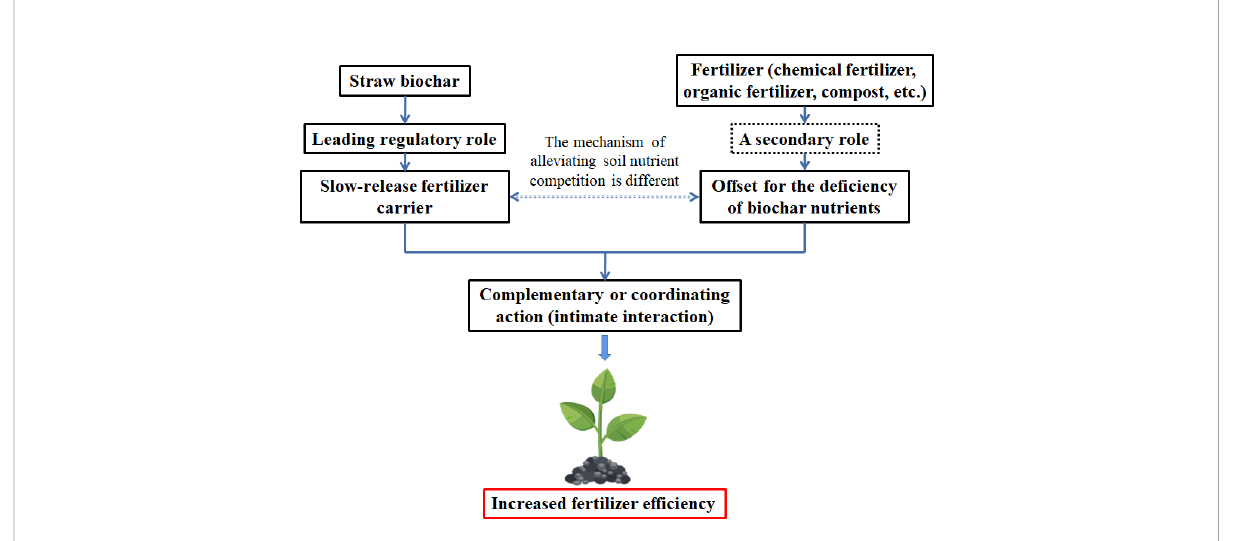
FIGURE 4 Straw biochar and fertilizer impact in soil for crop